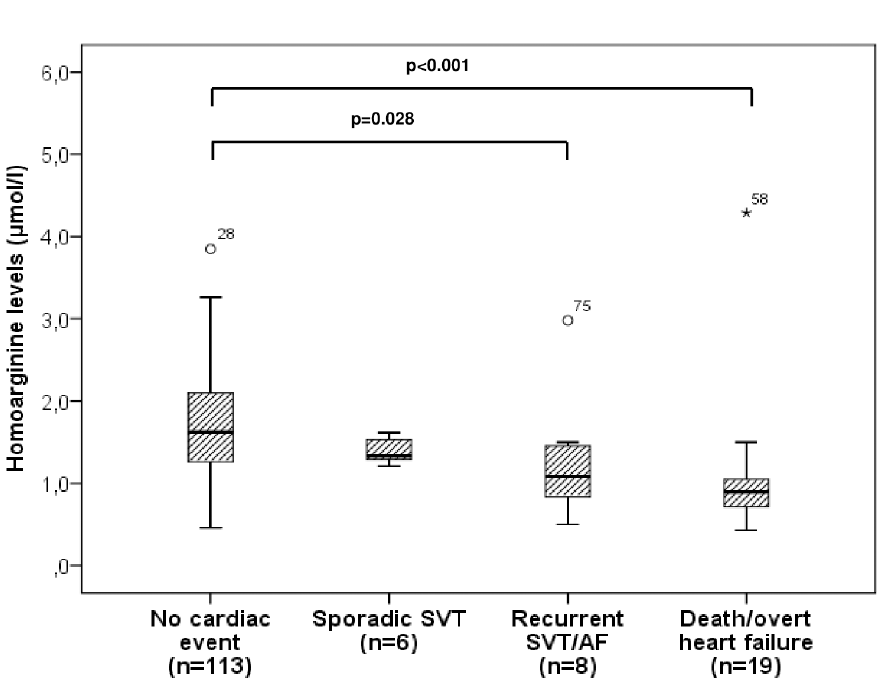
Fig 2. Boxplots demonstrating homoarginine levels in patients with different adversecardiac events. SVT, supraventricular tachycardia; AF, atrial fibrillation.